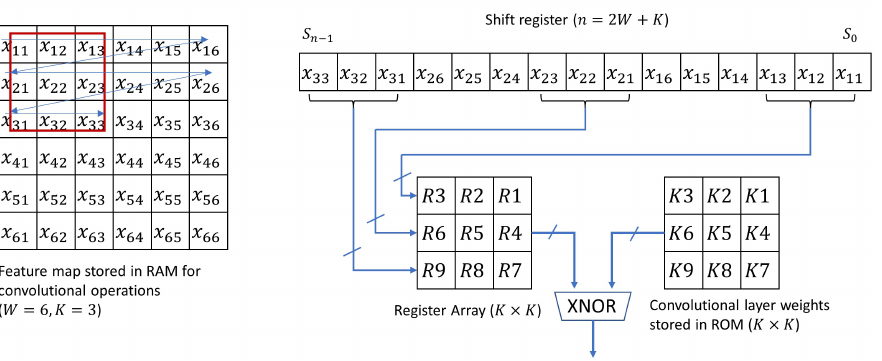
Figure 5. Shift register